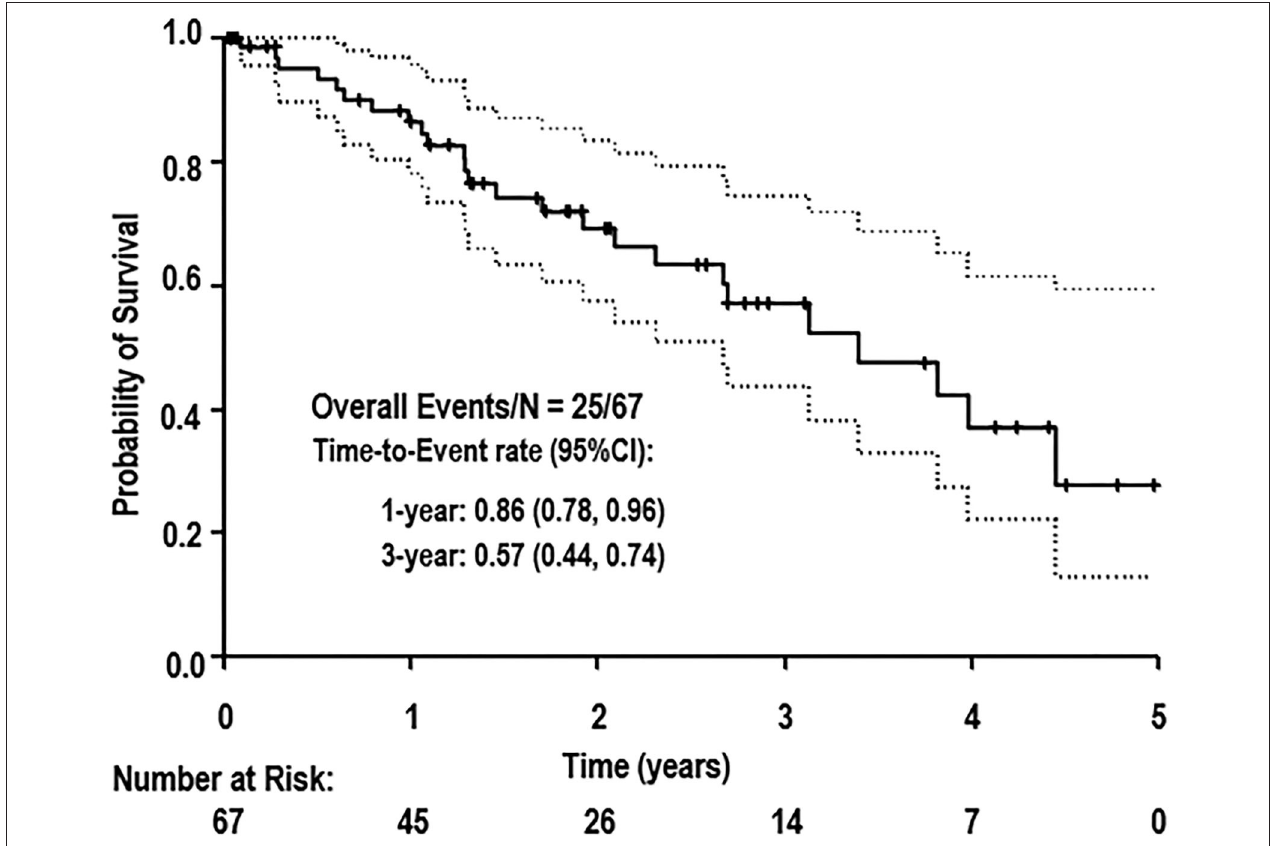
FIGURE 5 | Overall survival of studied population. Survival at 1 and 3 years